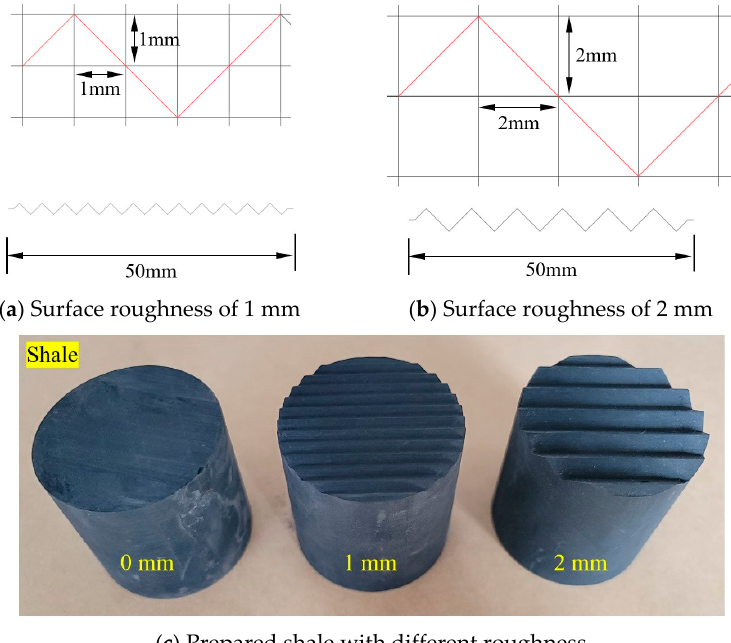
Figure 3. Roughness setting of rock surface.